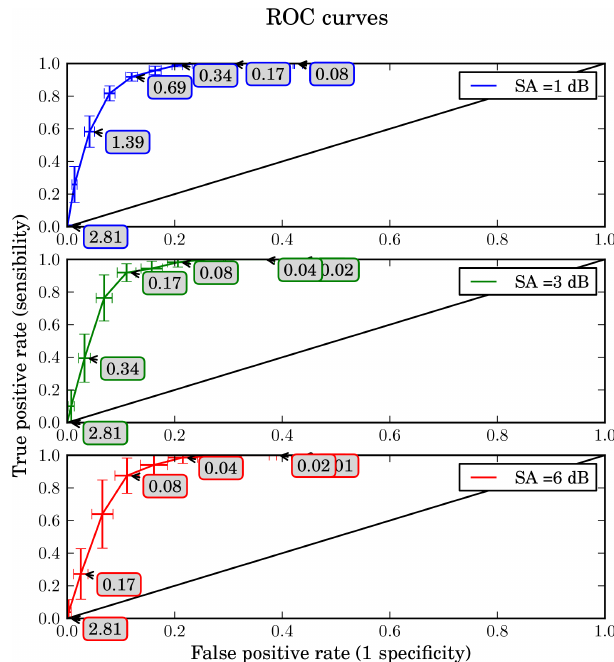
Figure 8. ROC curve obtained averaging the 100-fold cross val- idation for attenuation thresholds set to 1dB (blue), 3dB (green) and 6dB (red). The box plots indicate the standard deviation of each point. The diagonal line corresponds to random forecasts. If the curve is far from the diagonal, there is a high level of perfor- mance. The forecast probability D Th for each point (marked with an arrow) is indicated in the boxes in percent.